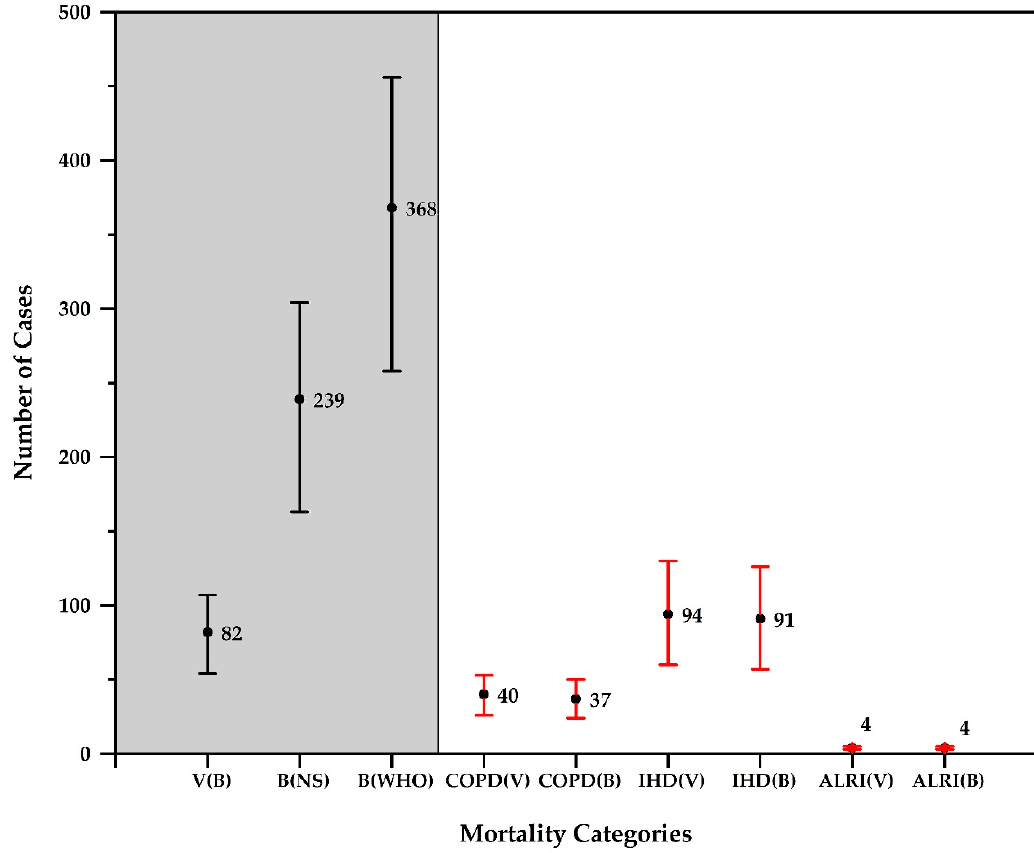
Figure 7. Premature mortality due to PM 2.5 for different causes (with high and low range) during the study period. V (B), B (NS), B (WHO), COPD (V), COPD (B), IHD (V), IHD (B), ALRI (V), and ALRI (B) represent mortality averted (shaded portion) and mortality caused (non-shaded portion). Where, V(B) is mortality averted when village concentration lowered to background level. B(NS) is mortality averted when background concentration lowered to NAAQS of Nepal. B(WHO) is mortality averted when background concentration lowered to WHO standards. COPD(V) is mortality caused due to PM 2.5 from background and village for chronic obstructive pulmonary disease. COPD(B) is mortality caused due to PM 2.5 from background only for chronic obstructive pulmonary disease. IHD(V) is mortality caused due to PM 2.5 from background and village for ischemic heart disease. IHD(B) is mortality caused due to PM 2.5 from background only for ischemic heart disease. ALRI(V) is mortality caused due to PM 2.5 from background and village for acute lower respiratory infection. ALRI(B) is mortality caused due to PM 2.5 from background only for acute lower respiratory infection.